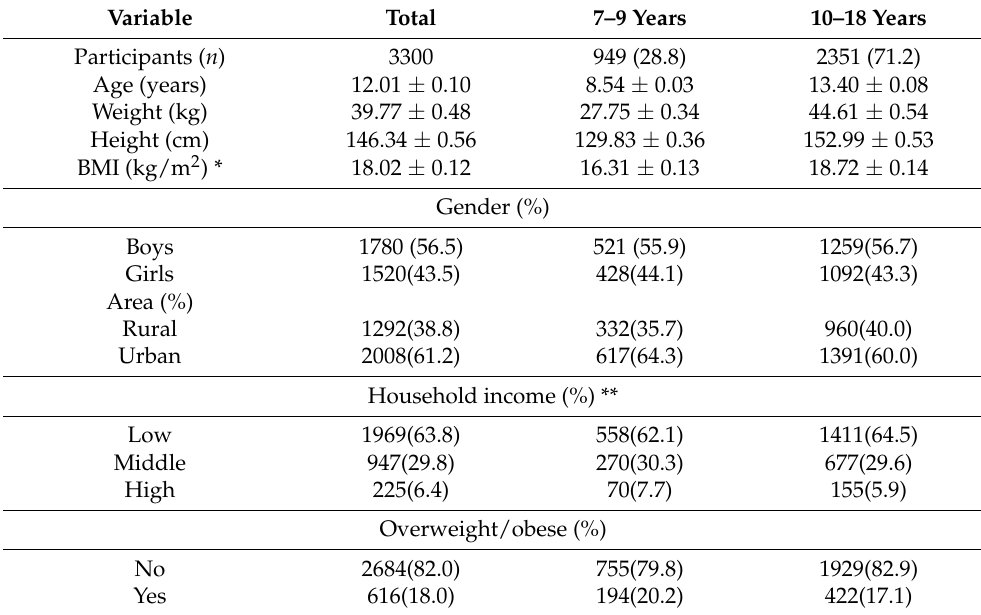
Table 1. Baseline characteristics among Chinese children and adolescents aged 7–18